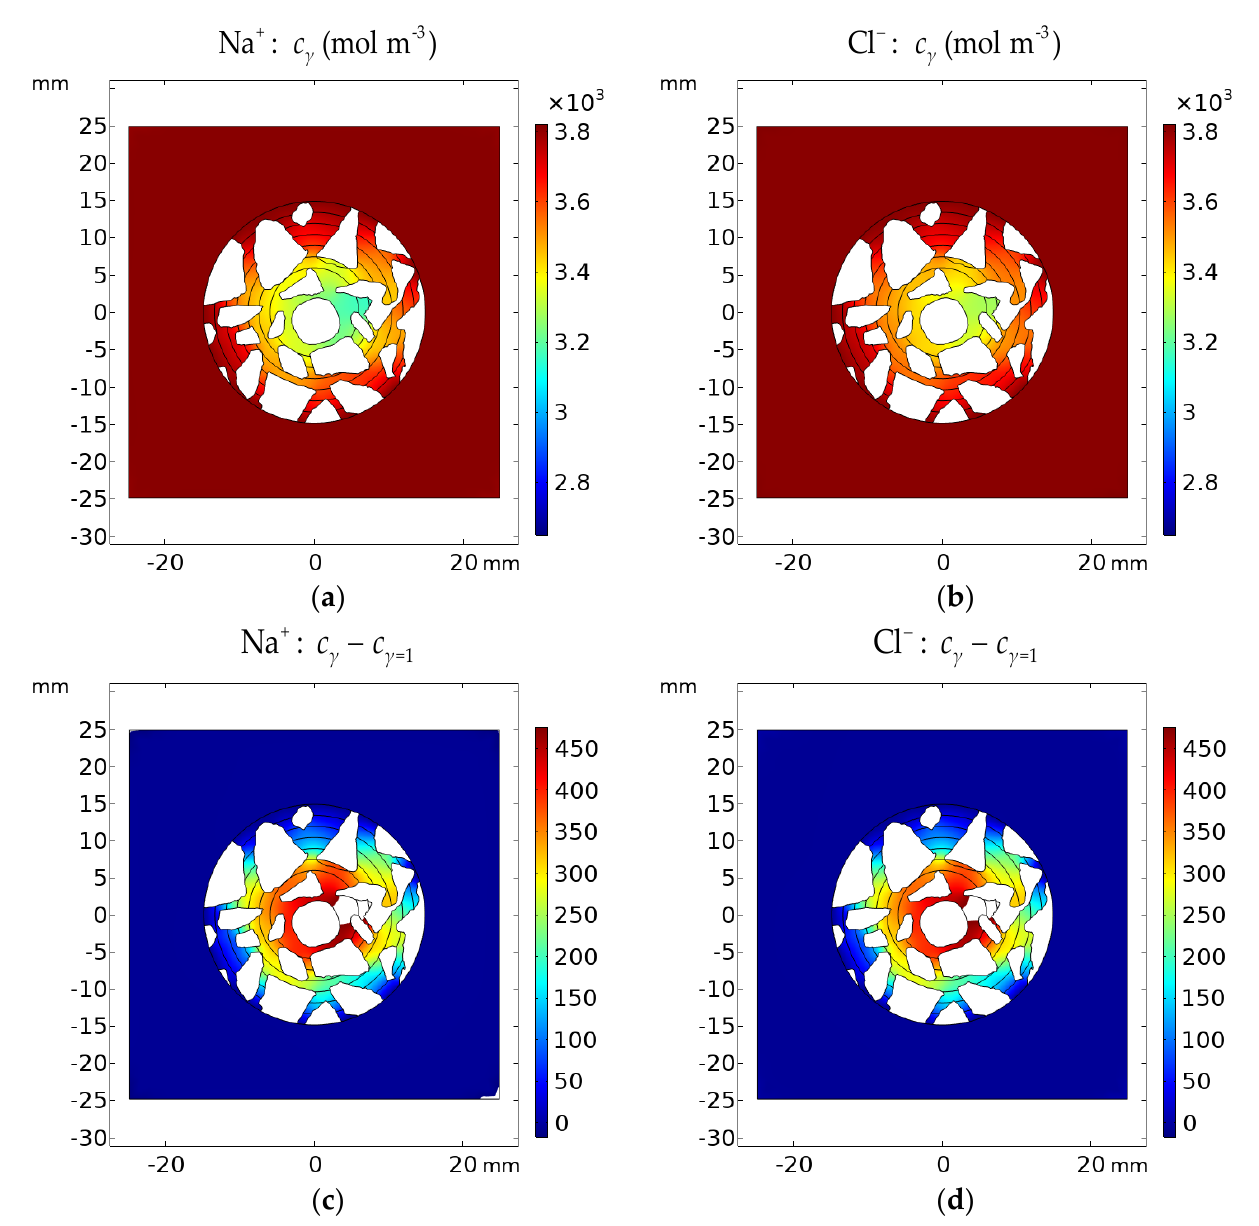
− in the cement sample after